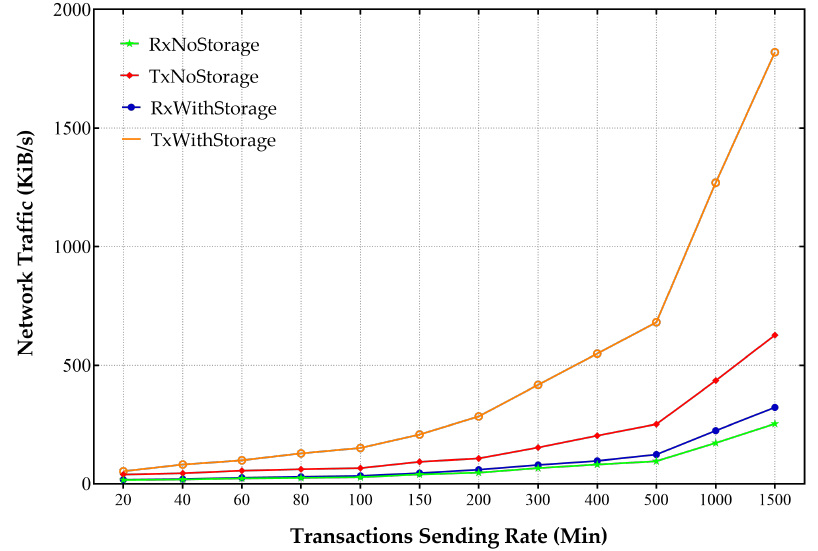
Figure 17. Network use vs. load sizes with/without external